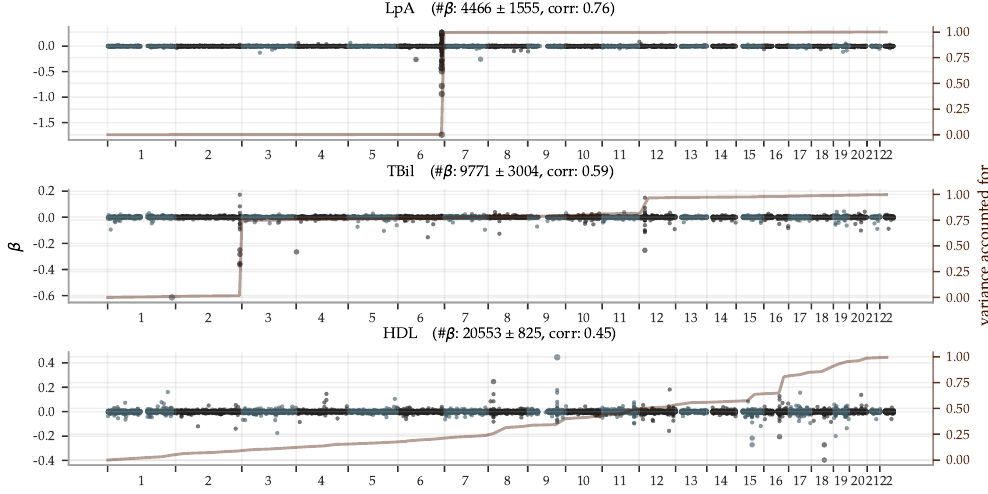
Figure 5. Manhattan plots of LASSO β —superimposed with the aggregate single SNP variance accounted for—show both highly localized, as well as widely polygenic architectures. The predictor for lipoprotein A is almost entirely determined by the well-known gene LPA in chromosome 6; the top 50 SNPs in this region account for ∼ 95% of the aggregate single SNP variance. In contrast, HDL has an almost uniform distribution of the variance accounted for across all the 22 autosomal chromosomes, despite some loci with high magnitude β -coefficients. (The difference being due to the MAF in Equation (1)). The most significant genetic loci are discussed further in the main text. The plot titles include the achieved PGS-phenotype correlation and mean number of non-zero β ± the standard deviation for the 5 predictors trained on each trait. Similar plots for all 65 biomarkers can be found in the Supplementary